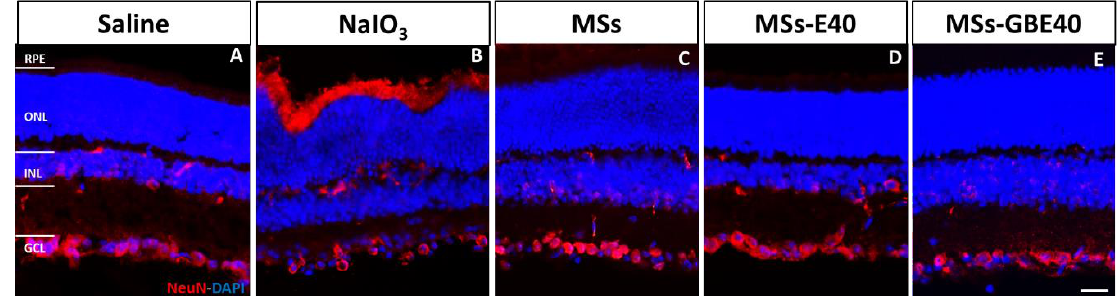
Figure 7. Immunofluorescent staining with anti-NeuN in mice retinas. NeuN (red) labeling is observed in a few cells in INL and mainly in GCL. Images show no alterations in GCL after intravitreal injection of saline ( A ), MSs ( C ), MSs-E40 ( D ) and MSs-GEB40 ( E ). Alterations in GCL were only found in sodium iodate injected animals ( B ). Nuclei of retinal cells were stained with DAPI (blue). Blank MSs (MSs); MSs/VitaminE(40) (MSs-E40), GDNF/BDNF/VitE(40)-loaded PLGA microspheres (MSs-GBE40). Scale bar: 20 µm. Abbreviations: RPE: retinal pigment epithelium, ONL: outer nuclear layer, INL: inner nuclear layer, GCL: ganglion cell layer.